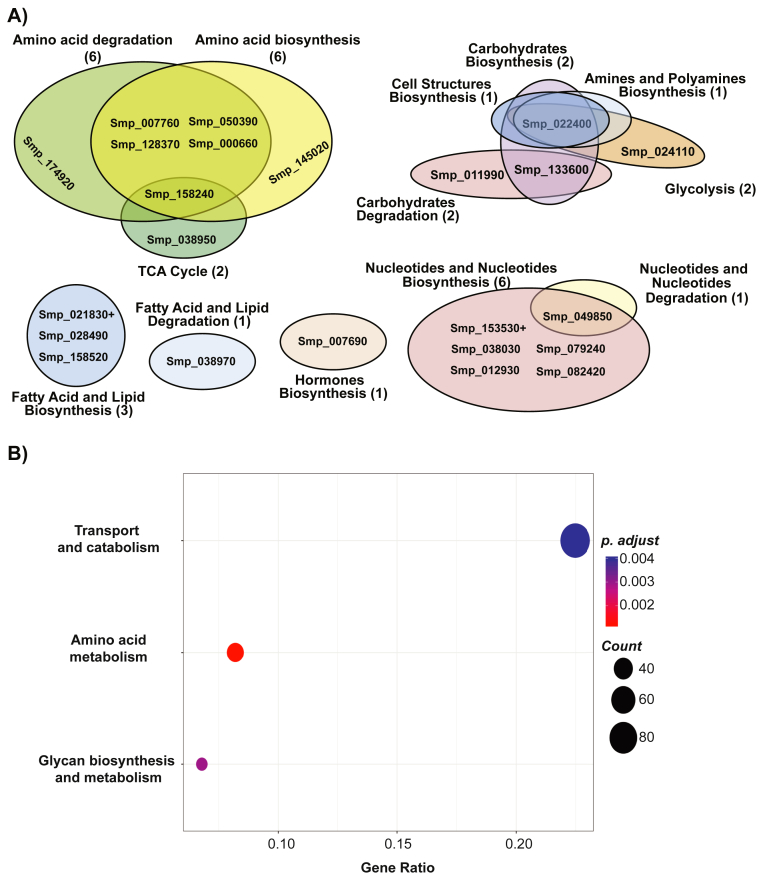
5-AzaC affects transcripts involved in metabolic processes. A) Venn diagrams of differentially expressed enzymes participating in metabolic pathways were produced using data from BioCyc (Caspi et al., 2016) and the Neo4j graph database. Smps found more abundantly expressed in 5-AzaC treated females are marked with a ‘+’. B) Scatter plot demonstrating significantly over-represented (p < 0.05) KEGG functional hierarchies by differentially abundant KEGG orthologs (KOs) between 5-AzaC-treated and control females for each dataset. Circle size represents KO counts within that pathway while red colouration represents lower p values and, therefore, higher significance. Gene ratio on the x-axis represents the proportion of genes represented in the pathway to the total number of DEGs. (For interpretation of the references to colour in this figure legend, the reader is referred to the Web version of this article.)